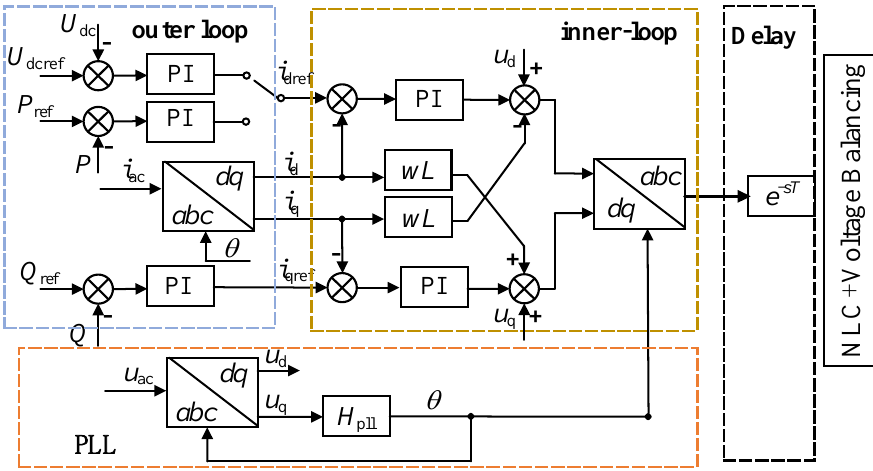
Figure 6. Simplified control structure of MMC mid-high-frequency modelling.